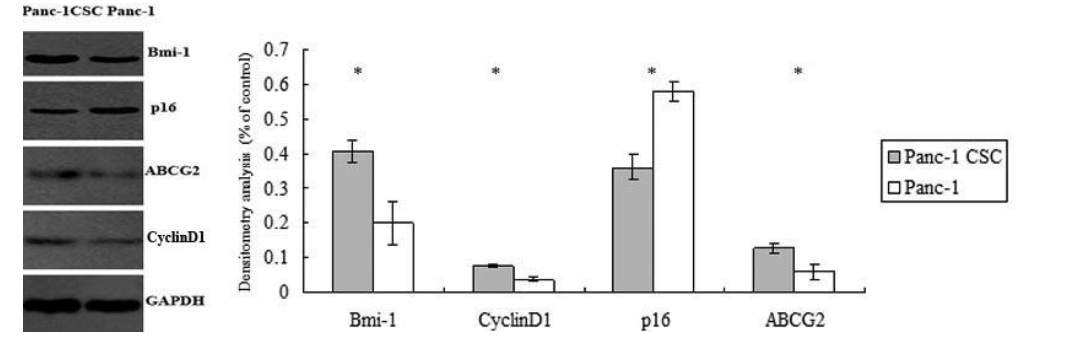
Figure 5. Abnormal expression of Bmi-1, ABCG2, Cyclin D1 and p16 in Panc-1 CSCs. The levels of Bmi-1, ABCG2 and p16 in Panc-1 CSCs and Panc-1 cells were determined by Western blot analysis and normalized to GAPDH (left). Densitometry analysis revealed the differences between Panc-1 CSCs and Panc-1 cells. * p <